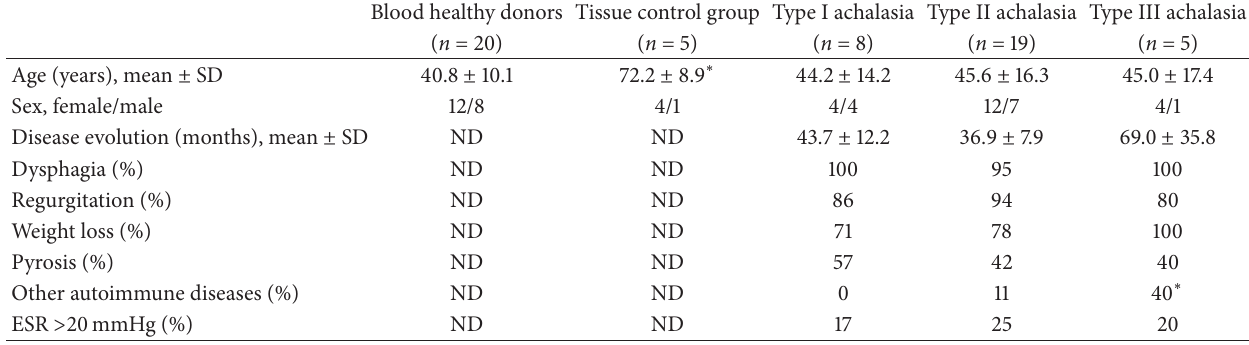
Table 1: Demographic, clinical, and laboratory